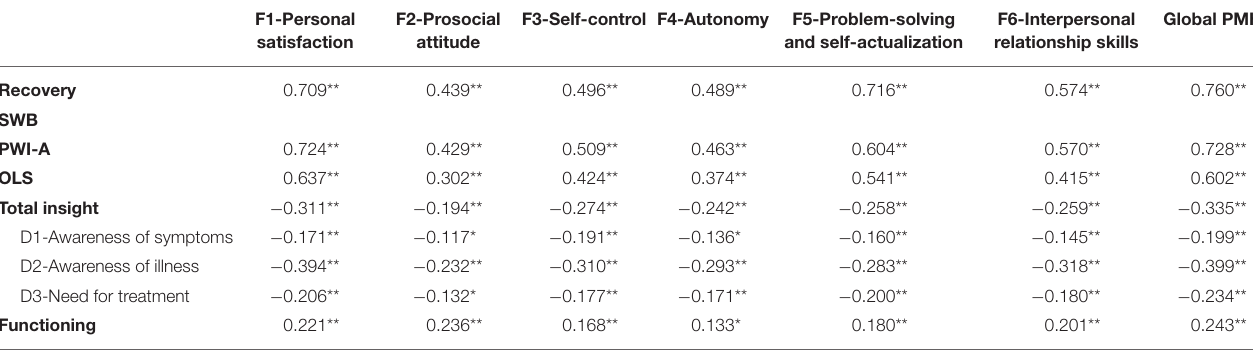
TABLE 3 | Pearson’s correlation between global PMH and by factors, recovery, SWB, insight and